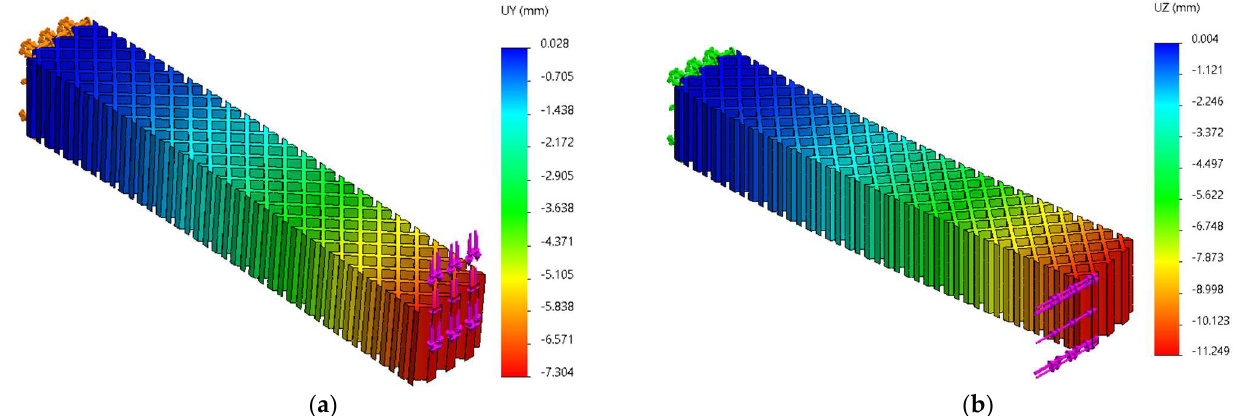
Figure 23. Cantilever beam. The displacement charts for the grid structure: ( a ) α = 0 ° , ( b ) α = 90 ° .